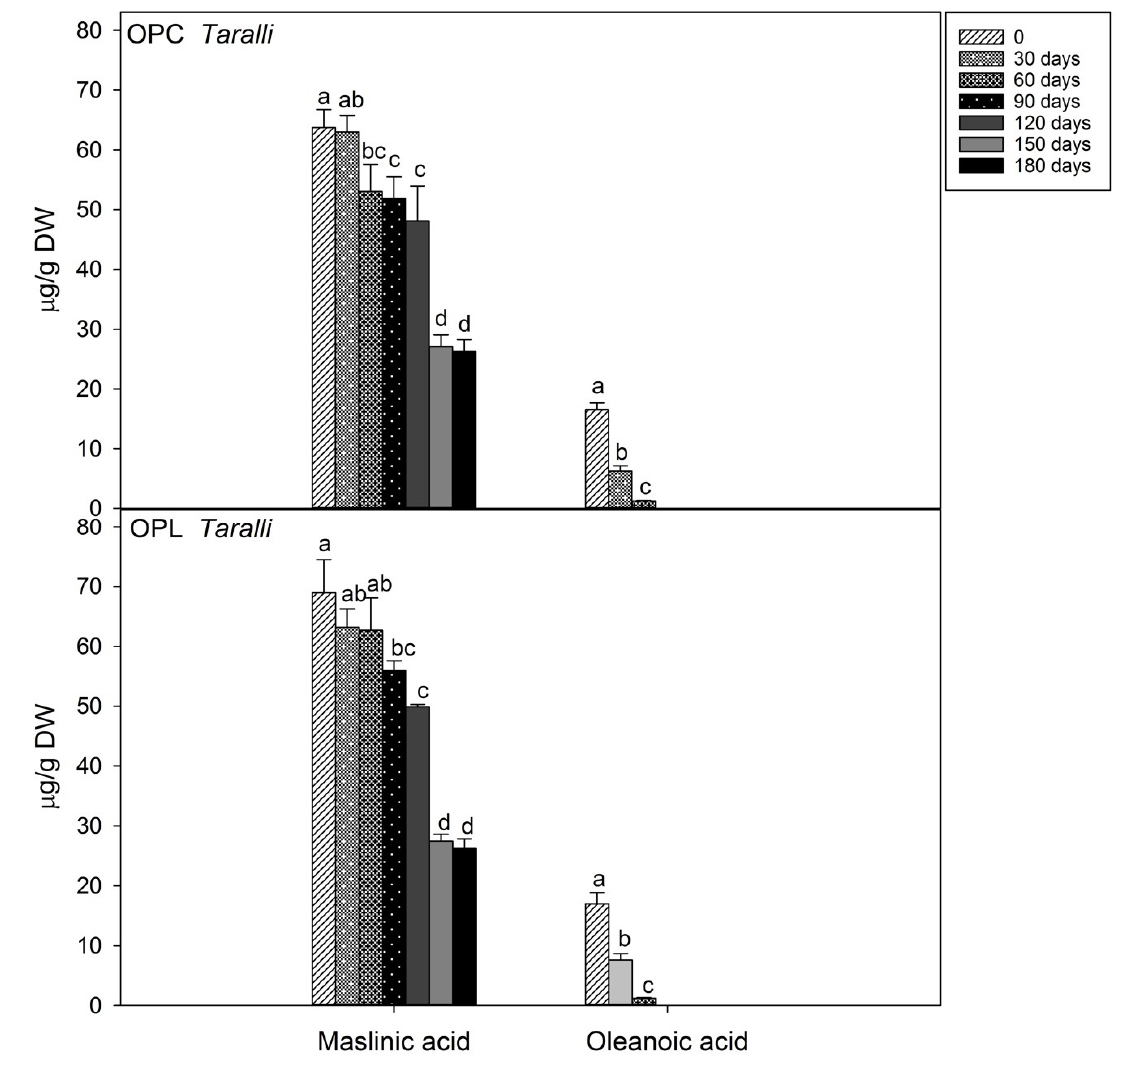
Figure 3. Time course of the amounts of triterpenic acids during the storage of CTRL and taralli enriched with fermented olive paste from Cellina di Nardò (OPC) or Leccino (OPL) olive cultivars at 25 °C, 500 lux, and in clear plastic bag for 180 days. Data are the mean ± standard deviation of three independent replicates ( n = 3). Data were submitted to one-way analysis of variance (ANOVA), Tukey’s test was applied to compare the experimental times (0, 30, 60, 90, 120, 150, 180 days) within the same sample for each compound (maslinic and oleanoic acid). Different letters mean significant difference at p < 0.05.